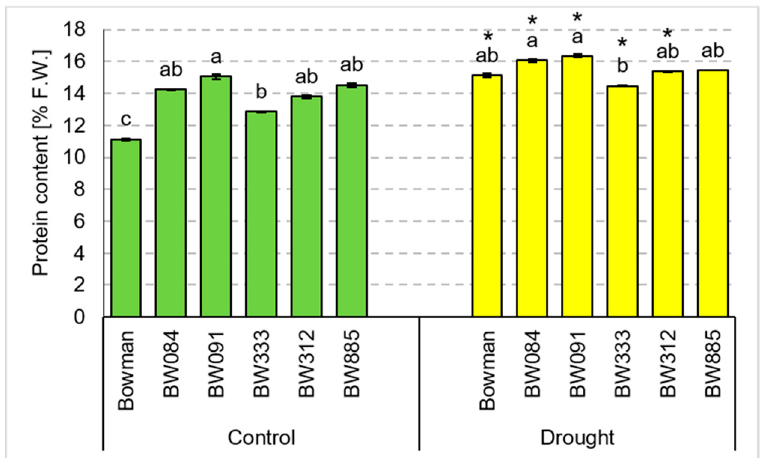
Figure 11. Total protein contents in grains of the analyzed genotypes under the optimal watering (control) conditions and after the drought stress (the pot experiment). The mean values ± (SD) marked with the same letters (separately for the control and drought-stressed plants) are not significantly different, according to Duncan’s test ( p ≤ 0.05). Asterisks denote significant difference in comparison of values reported in each genotype between the control and drought conditions according to Student’s t -test. Details are given in the text.